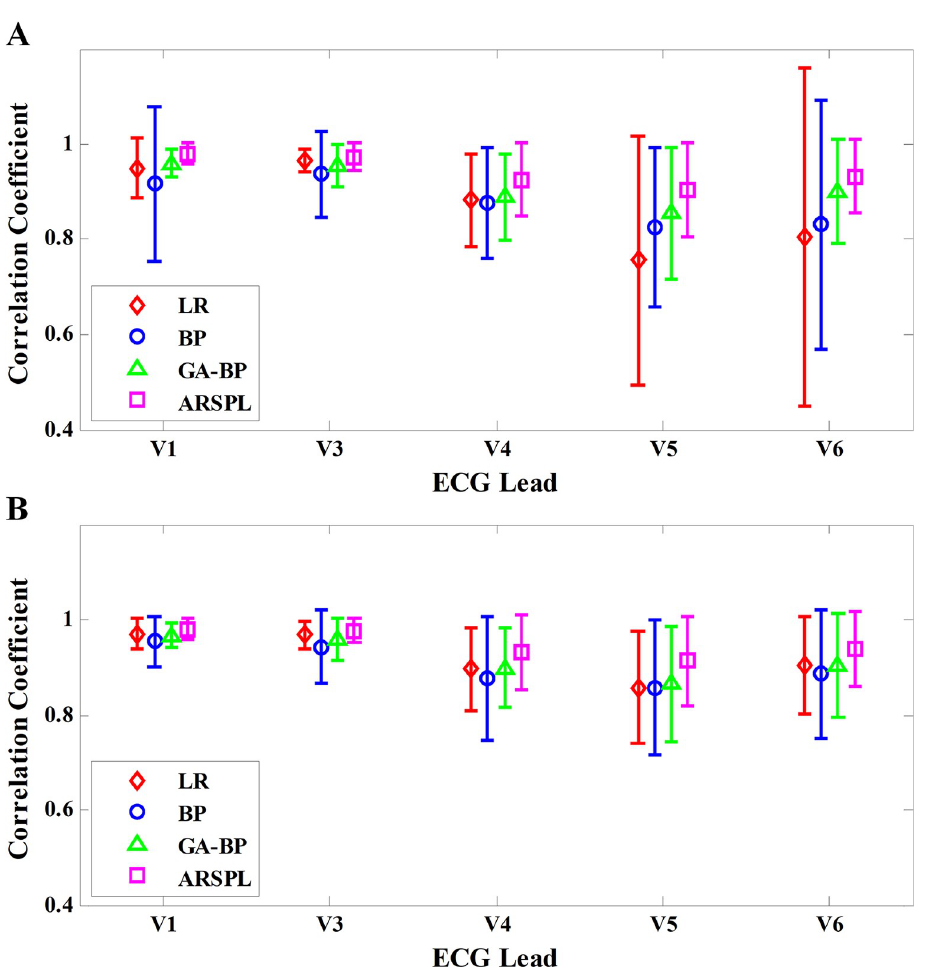
Fig 5. CC result of each lead for the basic/best cases. (A) CC comparison in the basic case. (B) CC comparison in the best case.